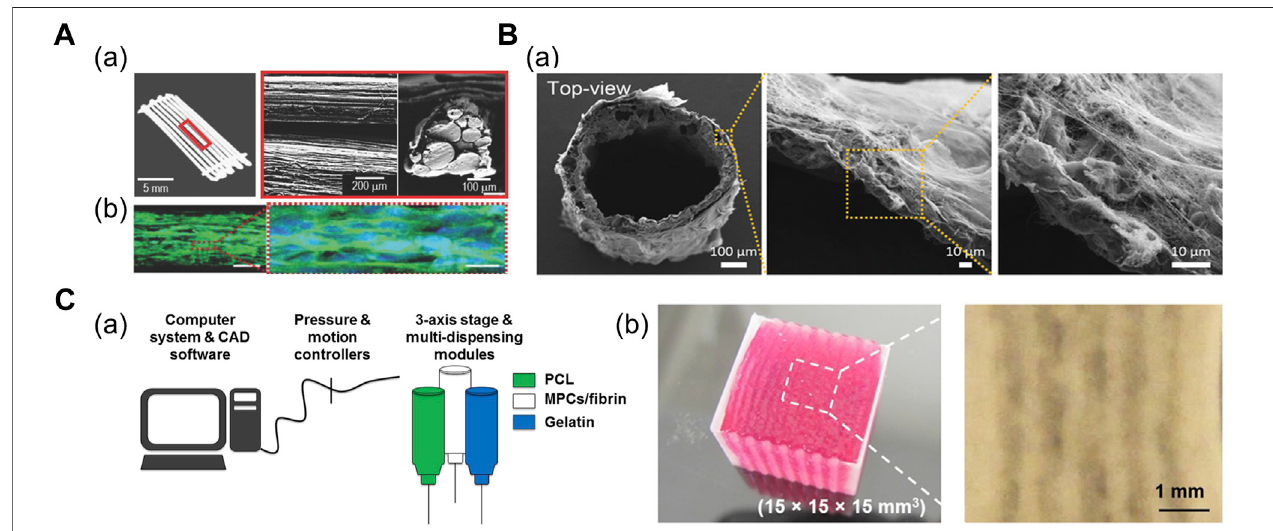
FIGURE 2 | (A) Fabrication of PCL strut-based 3D scaffold. (a) Optical and scanning electron microscopy (SEM) images of micropatterned PCL scaffold. (b) ConfocalimagesofcellsatDay14immunostainedformyosinheavychain(green)andnuclei(blue),indicatingthemyogenicdifferentiationinducedonthemicropatterned PCL scaffold. Reprinted with permission from (Kim et al., 2018a). (B) Fabrication of thermally drawn PCL- fi ber based 3D scaffold. (a) SEM images of PCL fi ber-based scaffold after dECM absorption on scaffold surface. Reprinted with permission from (Jin et al., 2021). (C) 3D bioprinted cell-laden construct with built-in channels. (a)Schematicofintegratedtissue-organprintingsystem.(b)3Dbioprintedmultilayeredmuscleconstructatscale:15 × 15 × 15 cm.Microchannelsareformedinsidethe construct after removal of gelatin patterns. Reprinted with permission from (Kim et al.,